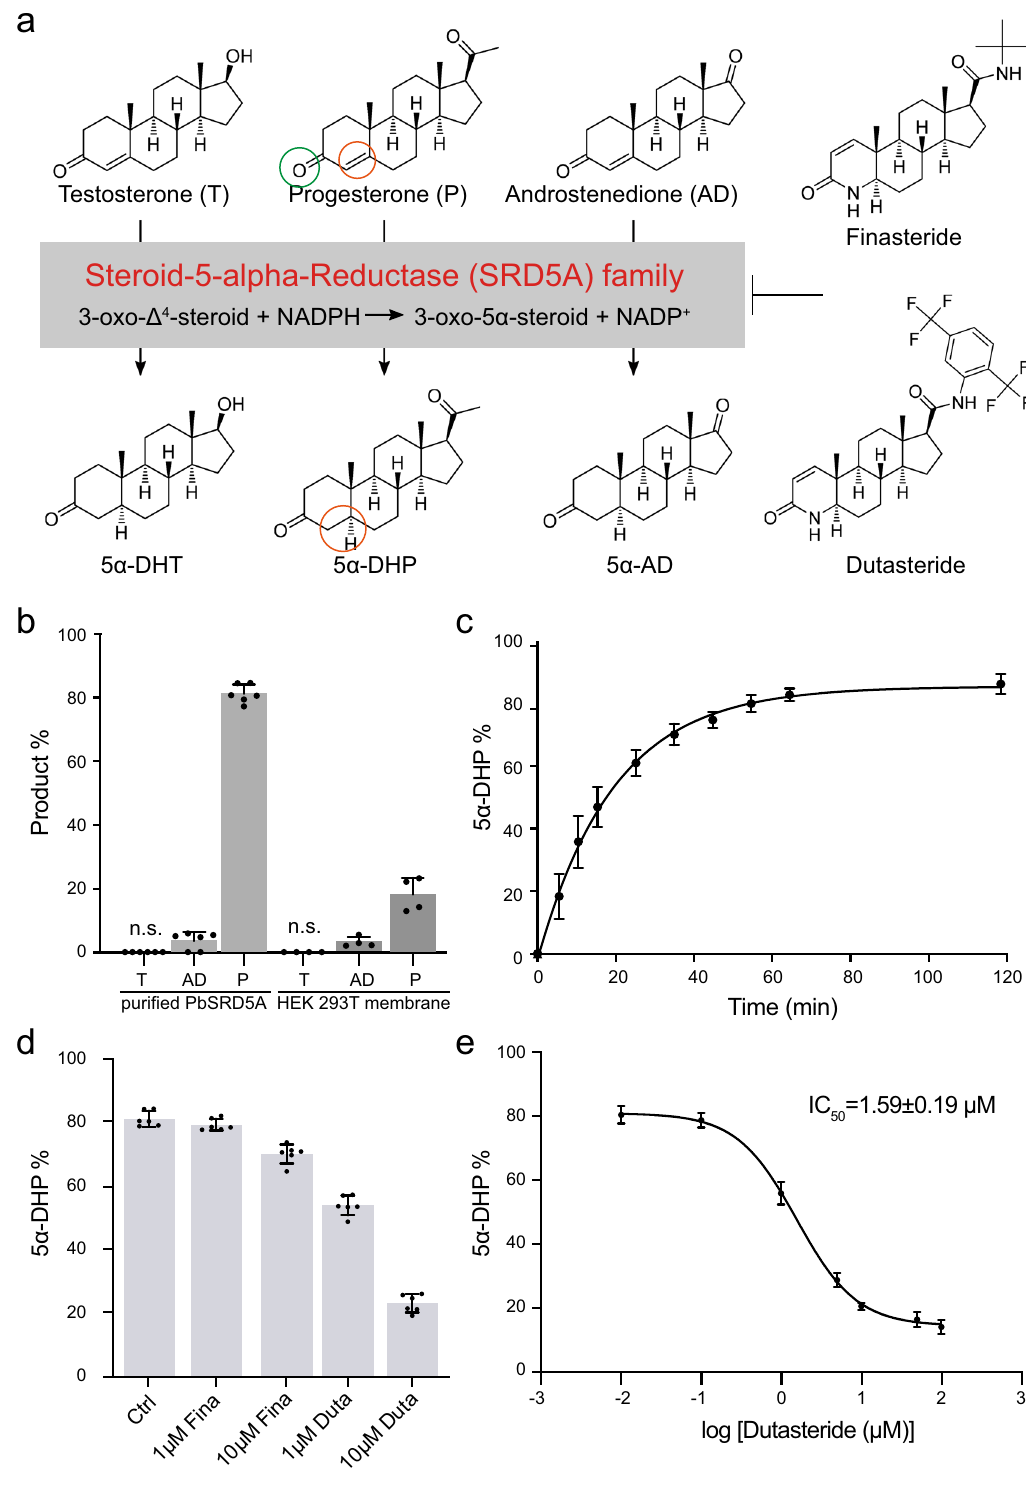
Fig. 1 Steroid 5 α -reductase activity of PbSRD5A. a Steroid 5 α -reductase family proteins can reduce Δ 4 carbon – carbon double bound to form α con fi guration at C 5 of products. These reactions can be inhibited by fi nasteride and dutasteride speci fi cally. b Testosterone (T), 4-androstene-3,17-dione (AD), and progesterone (P) metabolism in vitro and in HEK 293 T cell. Puri fi ed PbSRD5A and 293 T cells transiently transfected with PbSRD5A were treated with [ 3 H]-labeled T, AD, and P for 1 h and 12 h, respectively. n.s. means no signal. c Time curve of reduction reaction from progesterone to 5 α -DHP by PbSRD5A. d Inhibition of PbSRD5A by fi nasteride (Fina) and dutasteride (Duta) in vitro, both with the concentration of 1 μ M and 10 μ M, respectively. e Dutasteride inhibits the activity of PbSRD5A in vitro, with an IC50 value of 1.59 ± 0.19 μ M (logIC50 = 0.20 ± 0.05). b – e The percentages of products were measured using high-performance liquid chromatography (HPLC) with detected radioactivity. Data are mean±s.d. derived from technically independent experiments in duplicate. Each experiment was reproduced three times on separate occasions with similar